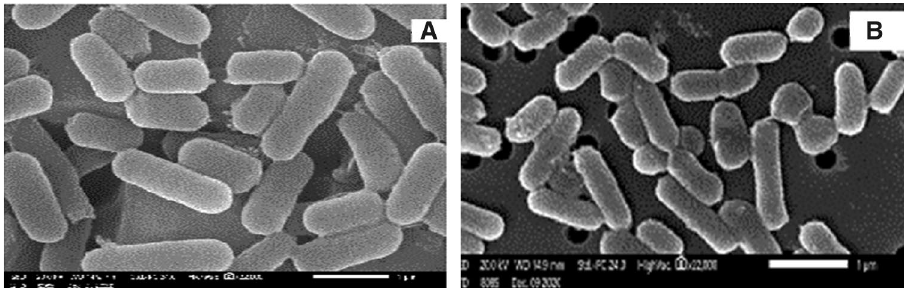
Figure 2. Scanning electron micrographs of cells; ( A ) overview of Lactobacillus acidophilus SAM1, ( B ) overview of Lactiplantibacillus plantarum SAM2.